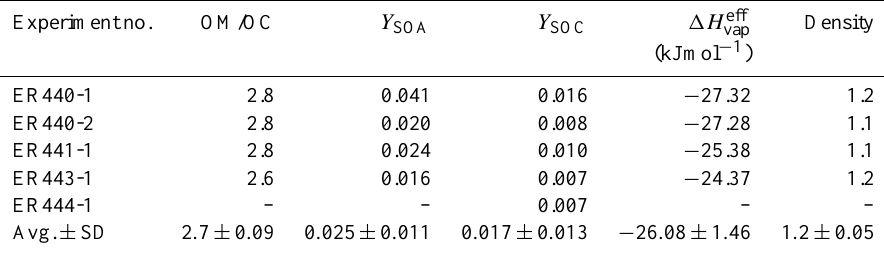
Table 4. OM / OC ratio, SOA and SOC yields, (cid:49)H eff vap , and density determined from 1,3-butadiene photooxidation from dynamic experiments. Experiment no. OM/OC Y